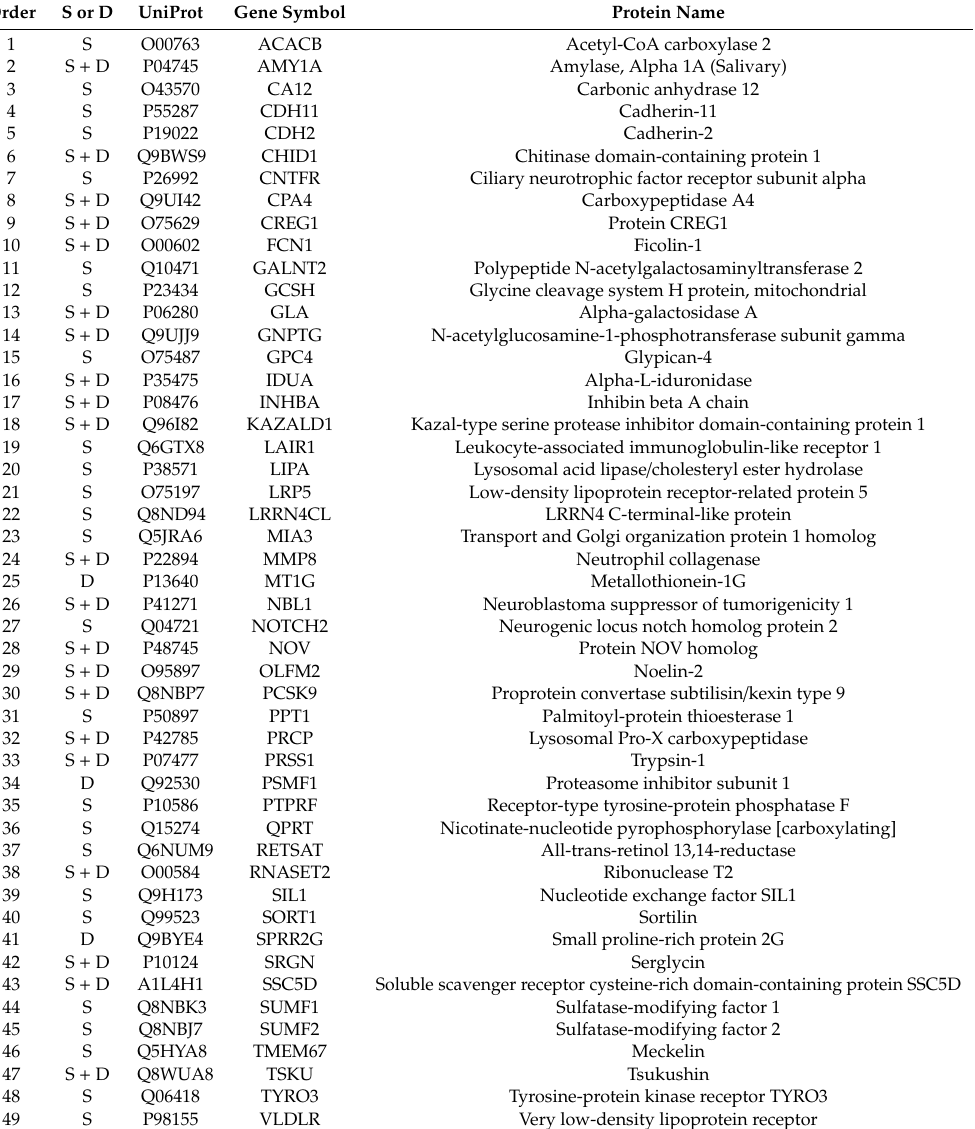
Table 2. List of 49 novel adipocyte secreted